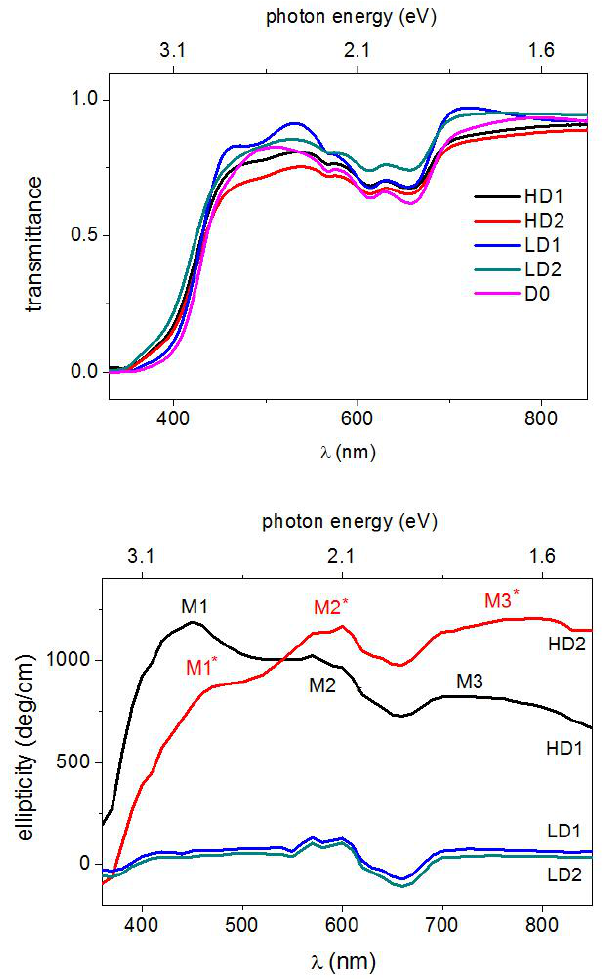
Figure 7. Transmittance (upper panel) and ellipticity spectra (lower panel) of the Zn 1 − x Co x O samples. Reproduced with permission from [74]. Copyright 2019 Royal Society of Chemistry.